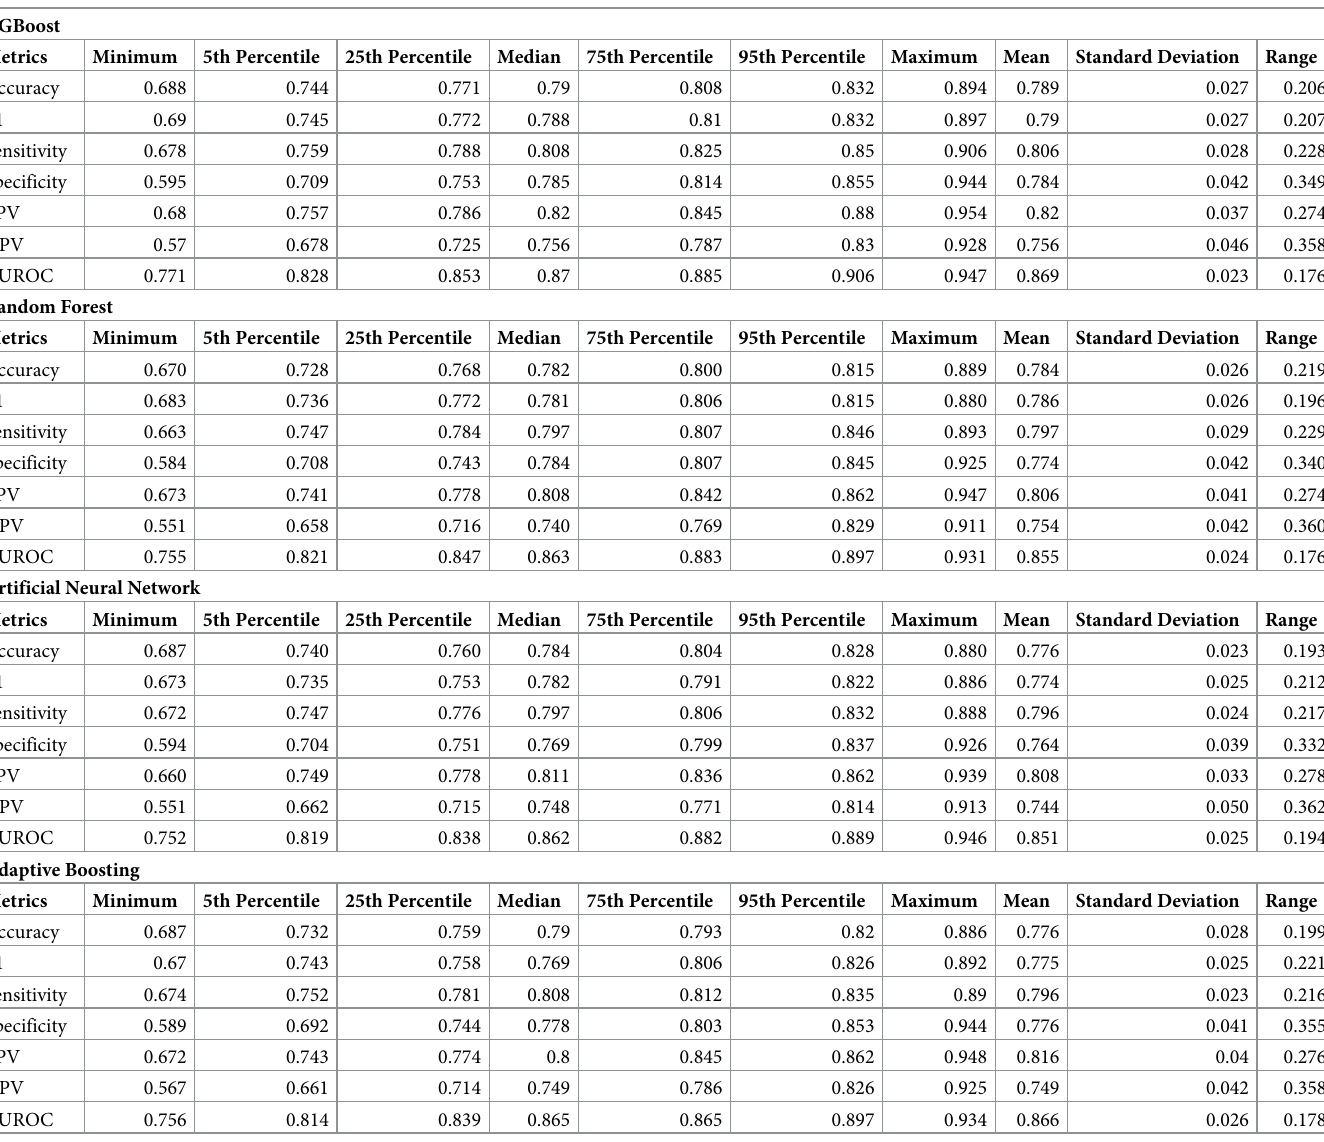
Table 2. Summary of model metrics for four machine-learning